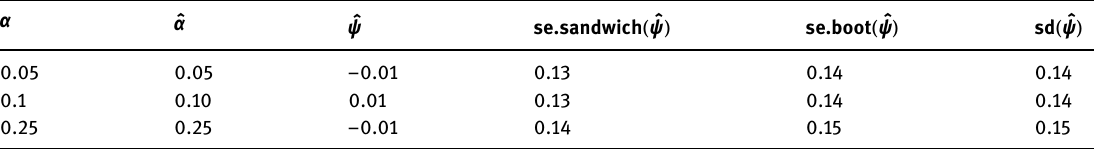
Table 4: Simulation results when using the estimated value of α in the estimation of ψ . Mean estimate α ˆ , and mean estimate ψ ˆ together with its mean sandwich standard error, mean bootstrap standard error, and its empirical standard